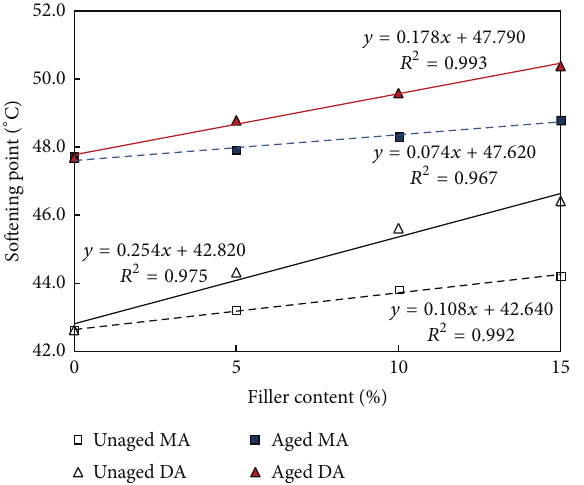
Figure 5: Softening points of asphalt mastics versus content before and after TFOT.